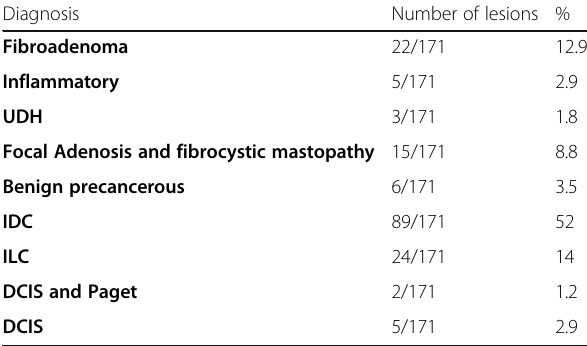
Table 1 The distribution of different pathological entities Diagnosis Number of lesions % Fibroadenoma